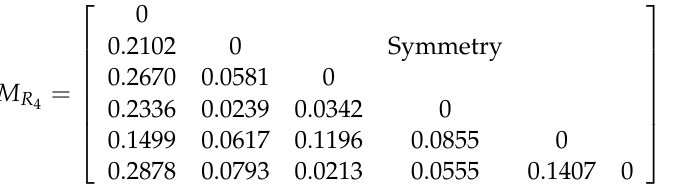
BM constructed with BPAs of R 2 . Figure 9. BM Figure 9. 2 R